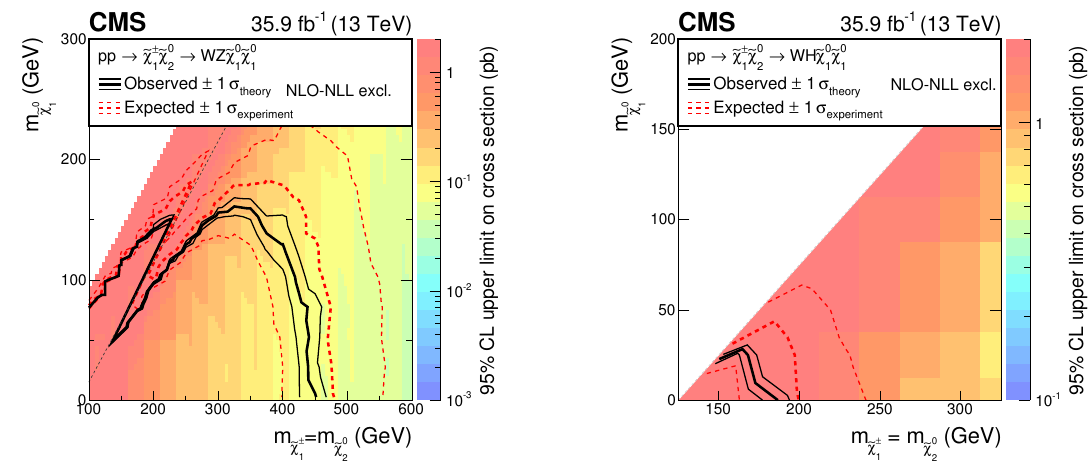
Figure 18 . Interpretation of the results in the of category A and the (cid:31) 0 dilepton, trilepton, and four-lepton). The shading in this (cid:12)gure is as described in (cid:12)gure 14. The dashed grey line on the left plot corresponds to a mass di(cid:11)erence between the (cid:31) 0 the Z